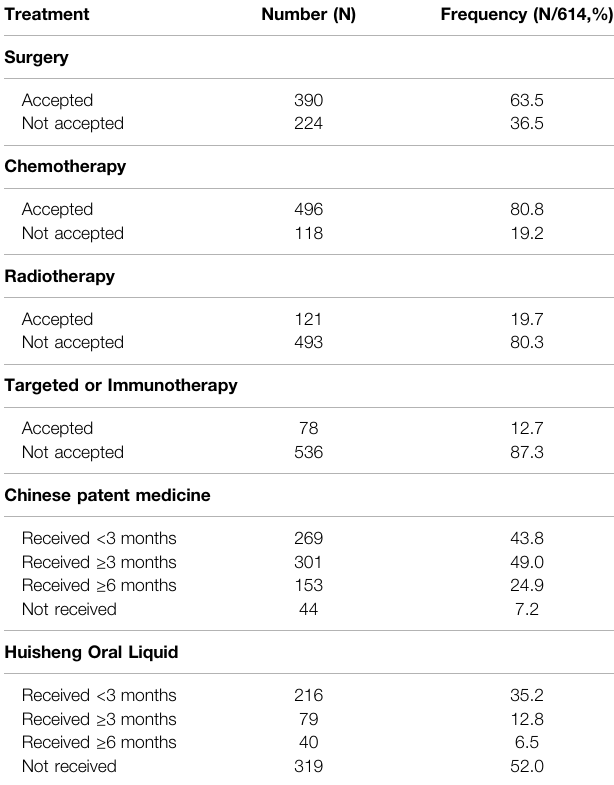
TABLE 1 | Overview of all treatment in 614